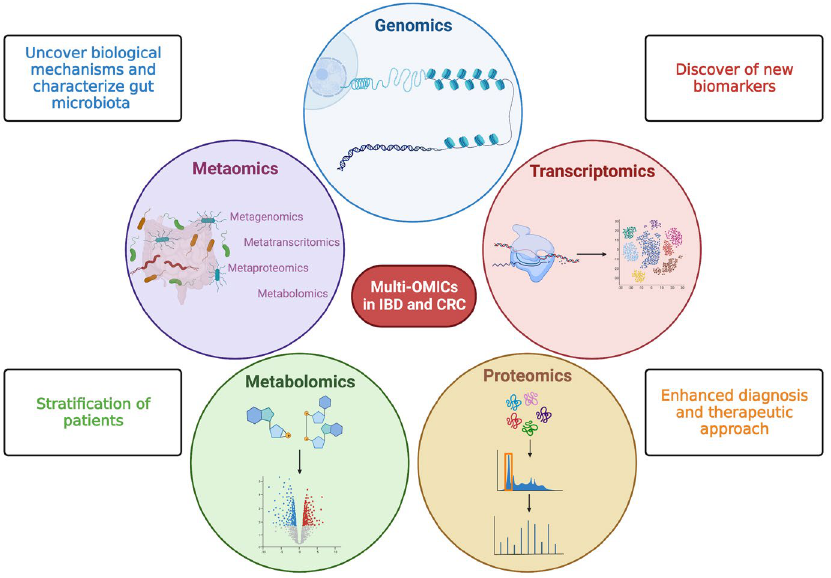
Figure 2. Multi—OMICs and its impact on inflammatory bowel disease and colorectal cancer.